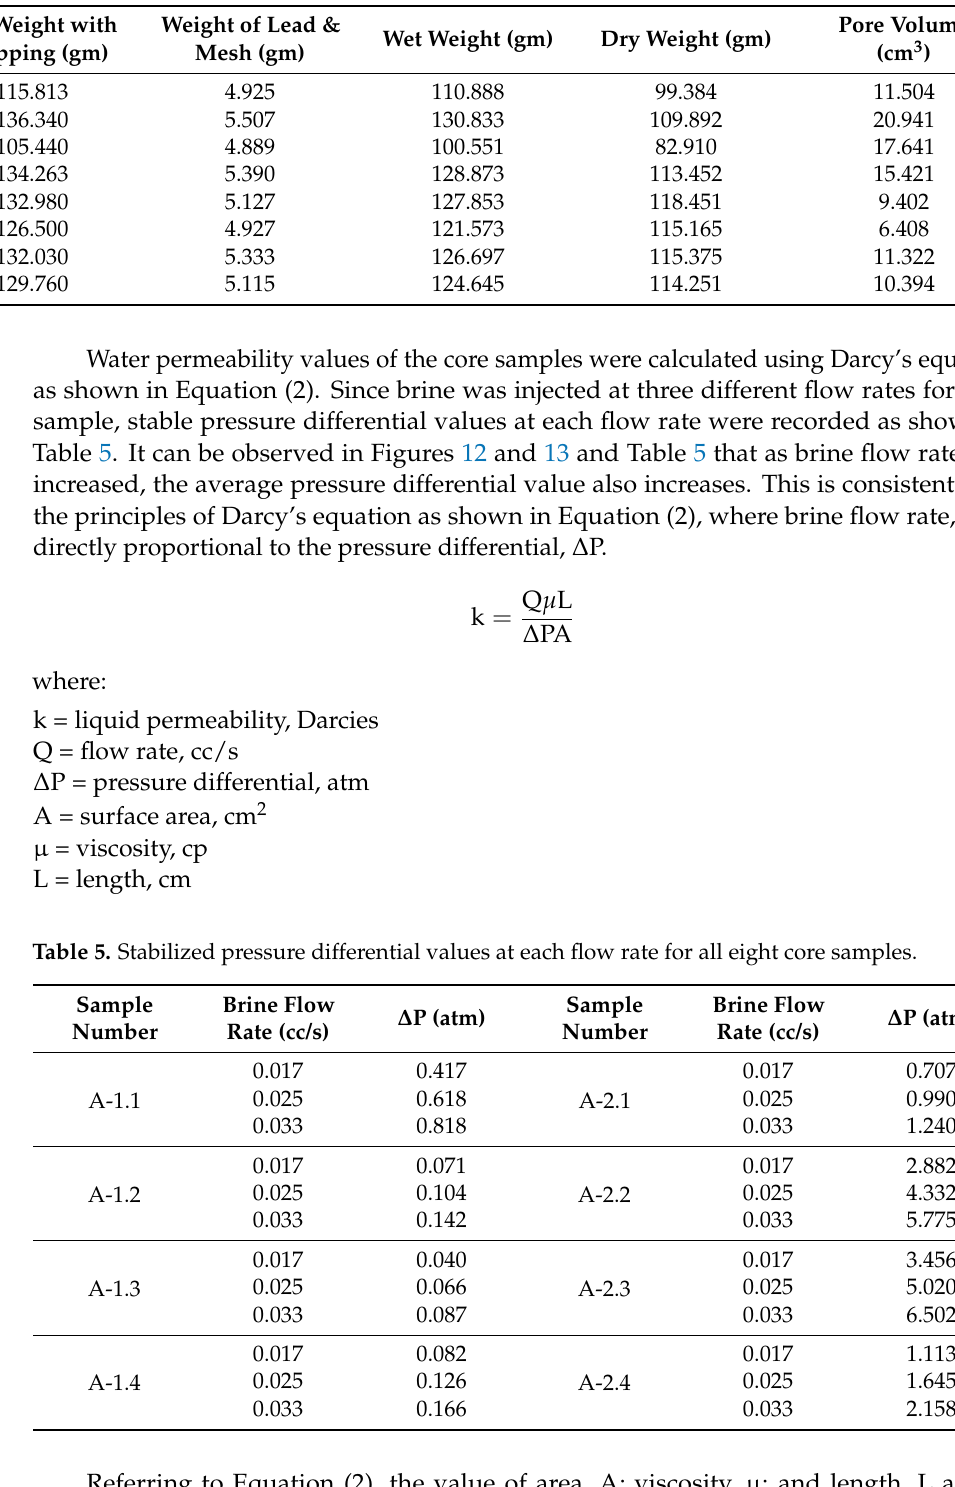
Table 4. Values of WW, WLM, DW and pore volume of PETRONS core plug samples.